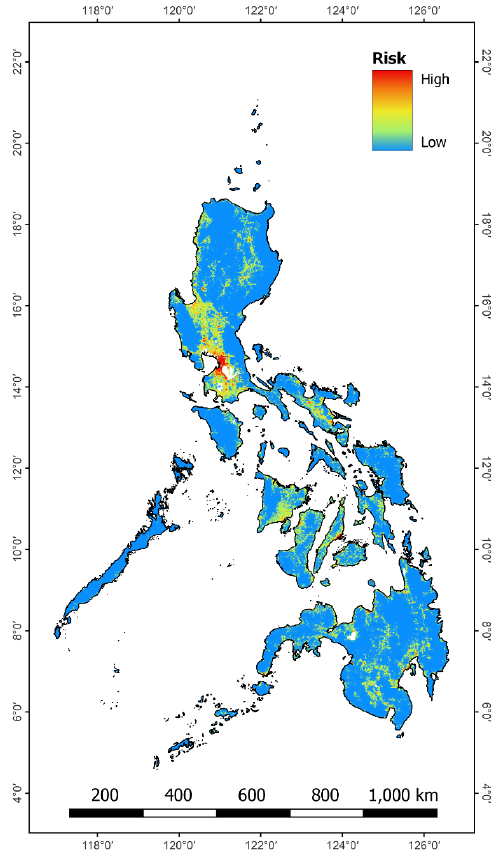
Figure 9. The urban heat risk map revealed that the urban populated areas are more likely to experience the impact of extreme